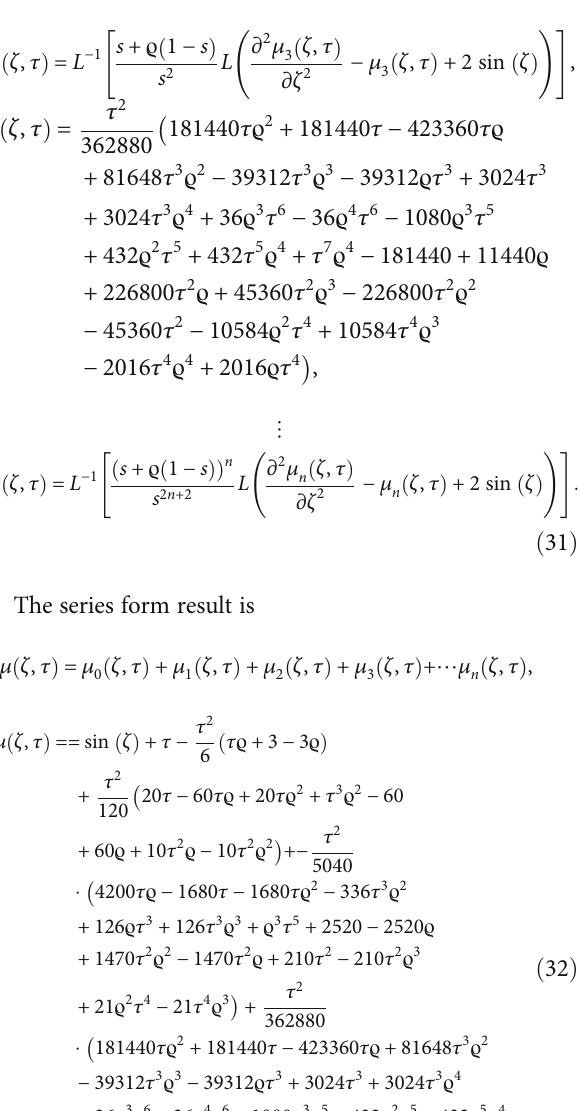
Figure 2: The di ff erent fractional-orders with respect to ζ and τ of problem